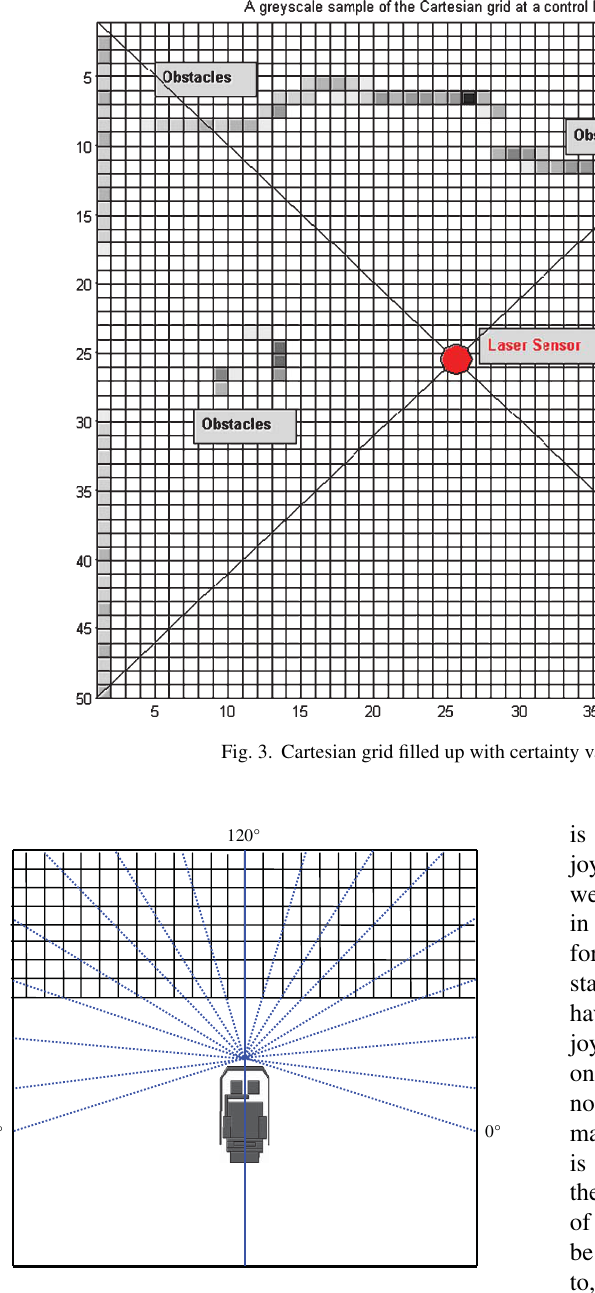
Fig. 4. Cartesian grid split into